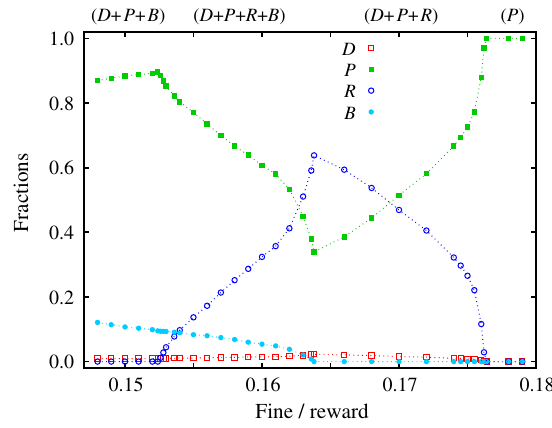
FIG. 2. Enlarged part of the full (cid:1) (cid:1) (cid:2) phase diagram de- picted in Fig. 1, zooming in on the very small (approximately 10 3 smaller than (cid:1) ) values of (cid:2) . Solid red lines denote con- tinuous phase transitions, while the dashed blue line denotes discontinuous phase transitions. Discontinuous phase transitions are due to indirect territorial competition between strategies P and B , which compete independently against the defectors. A representative cross section of the phase diagrams is presented in Fig.